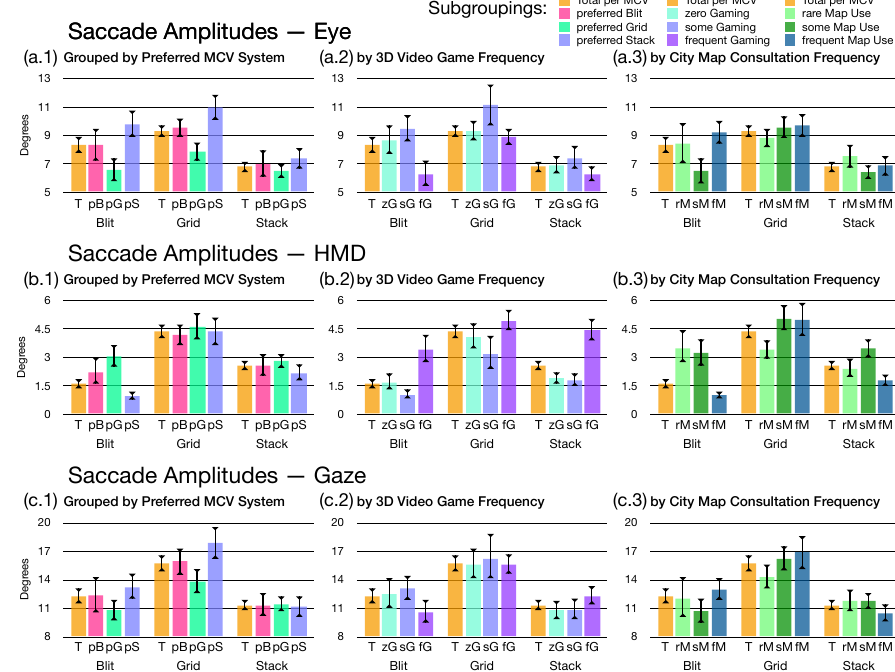
Figure 10. Average saccade amplitude measurements for each MCV system (blit/grid/stack): split by the eye (or viewport) component ( a ), the head movement (or HMD rotation) component ( b ), and taken together to determine the overall gaze ( c ). Further subgrouped by the participants’ preference for an MCV system regarding its legibility (1), the frequency with which they play video games (2), and the frequency with which they consult city maps